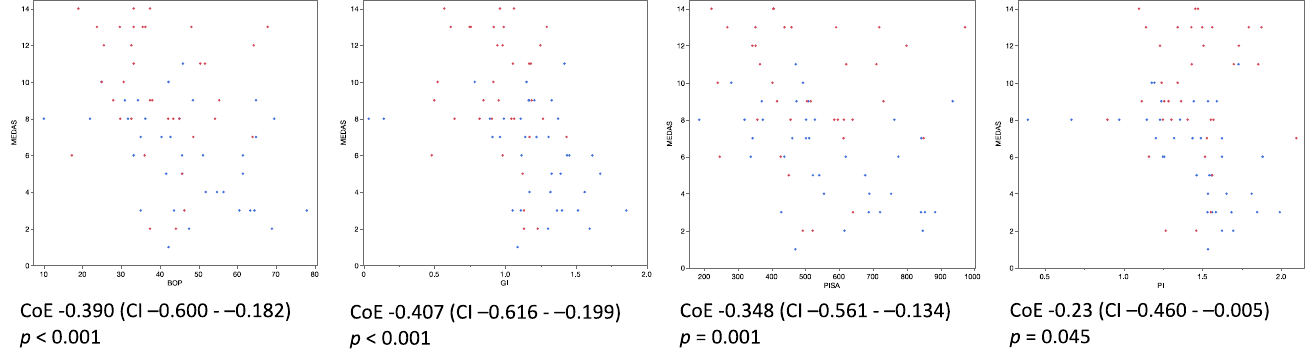
Figure 3. Correlation between the MEDAS score and clinical parameters (BOP, GI, PISA and PI). Scatterplots; data from T 0 0 (blue) and T 2 (red) for both groups ( n = 73). MEDAS = Mediterranean Diet Adherence Screener, BOP = bleeding on probing, GI = gingival index, PISA = periodontal inflammation surface area, PI = plaque index, CoE = correlation estimate, CI = 95% confidence interval.